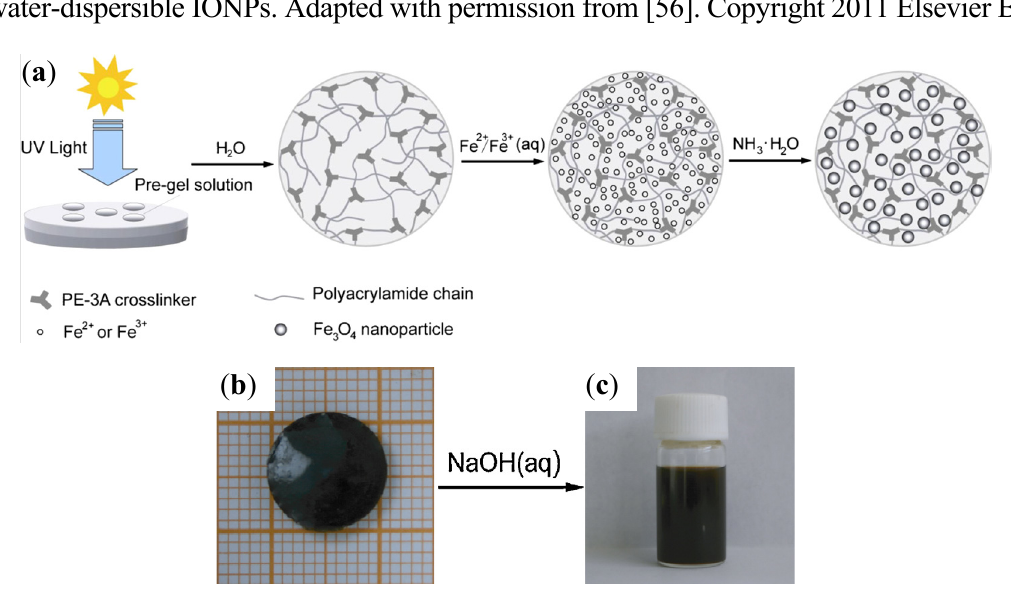
O NPs synthesized by 3 4 O NPs for samples containing the cross-linker 3 4